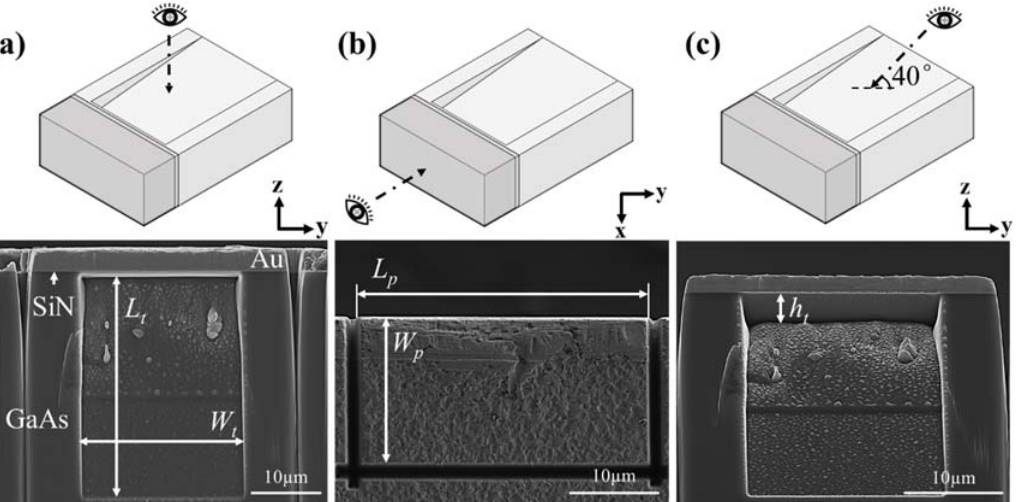
Figure 3. SEM micrographs of a typical FIB-milled push-out specimen (specimen S2, see Table 2 for details): ( a ) cross-sectional view; ( b ) top surface showing the Au panel; and ( c ) side view with 40 ◦ tilting angle showing the